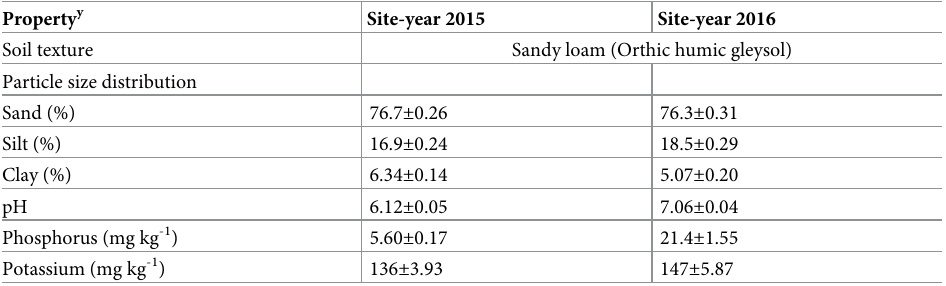
Table 1. Select soil z properties from 0–15 cm depth at Ridgetown, Ontario, Canada during 2015 and